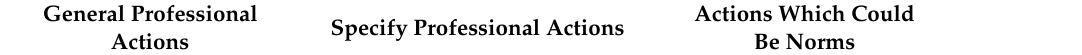
Table 4. Professional actions and actions which could be norms in Episode